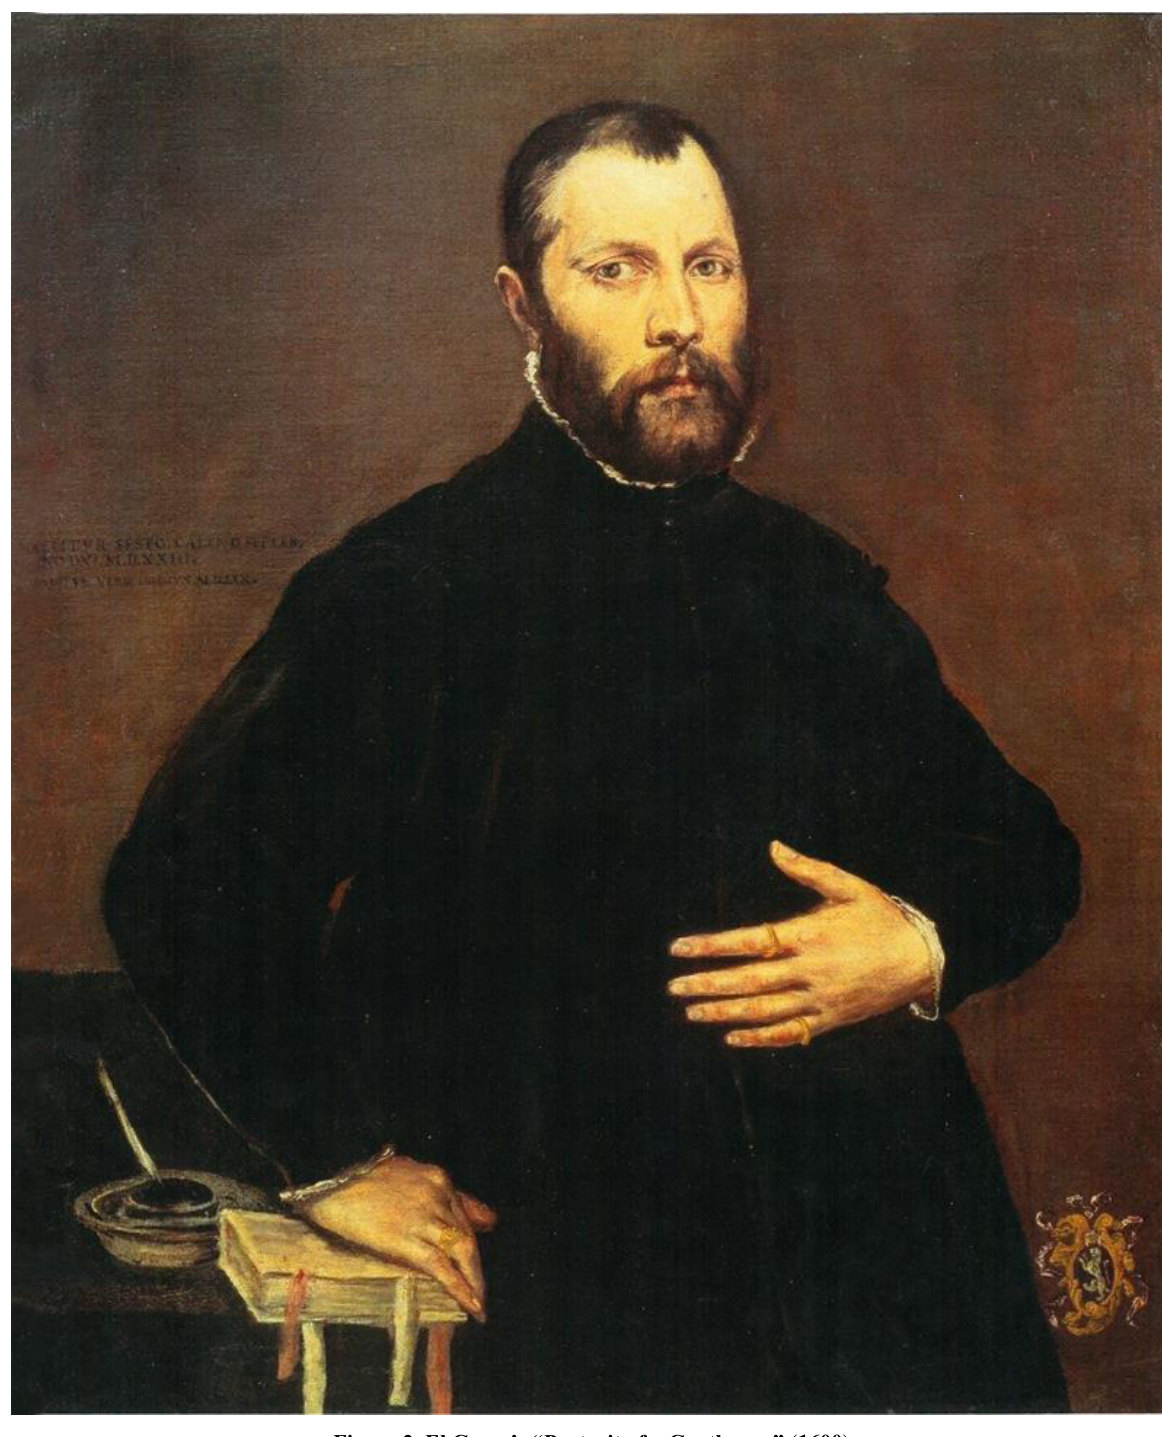
Figure 2. El Greco’s “Portrait of a Gentlemen”